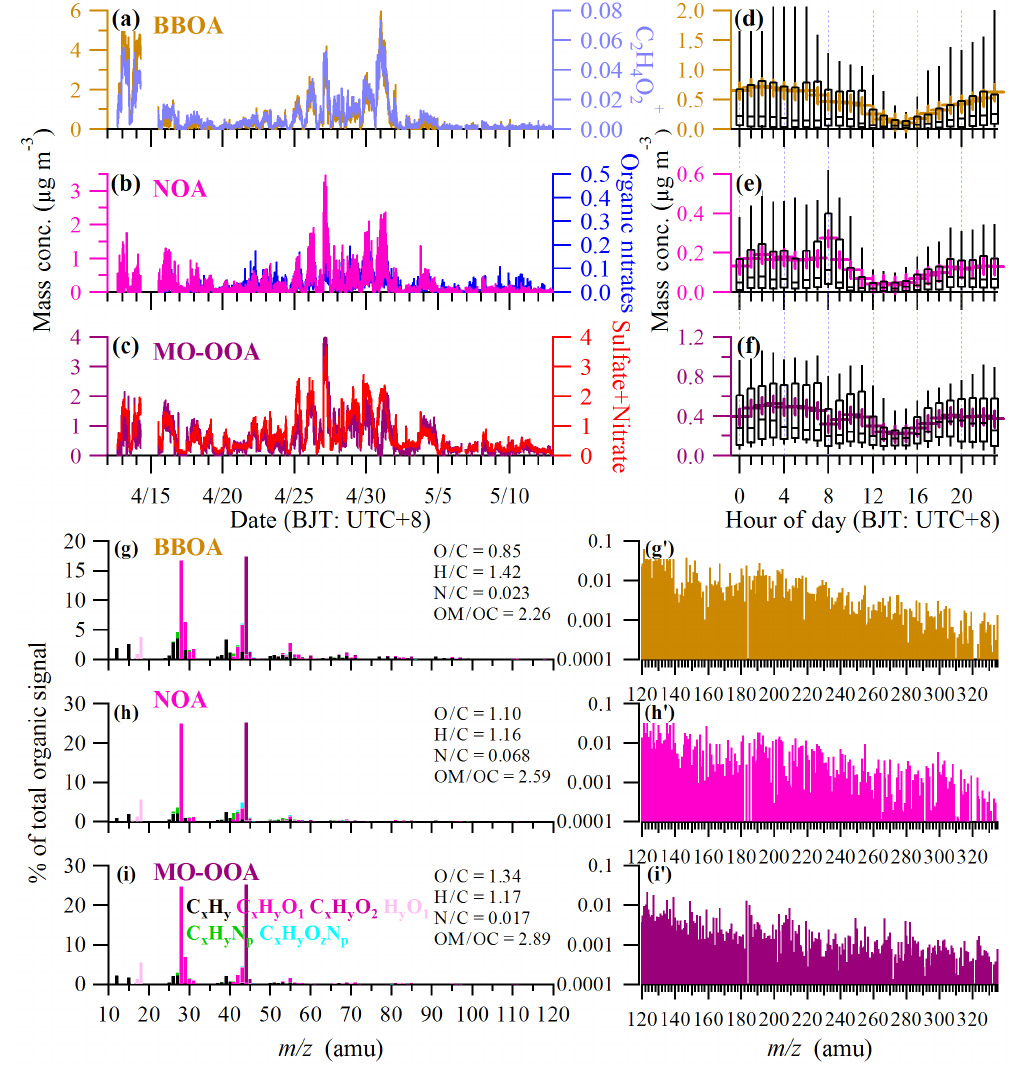
Figure 7. The PMF results of (a) – (c) the time series of three OA factors and corresponding tracer species, (d) – (f) the diurnal variations of the mass concentrations of the three OA factors (the whiskers above and below the boxes indicate the 90th and 10th percentiles, the upper and lower boundaries respectively indicate the 75th and 25th percentiles, the lines in the boxes indicate the median values, and the cross symbols indicate the mean values), (g) – (i) high-resolution mass spectra of the three OA factors colored by six ion families at m/z < 120, and (g’) – (i’) the unit resolution mass spectra at m/z > 120 for each OA